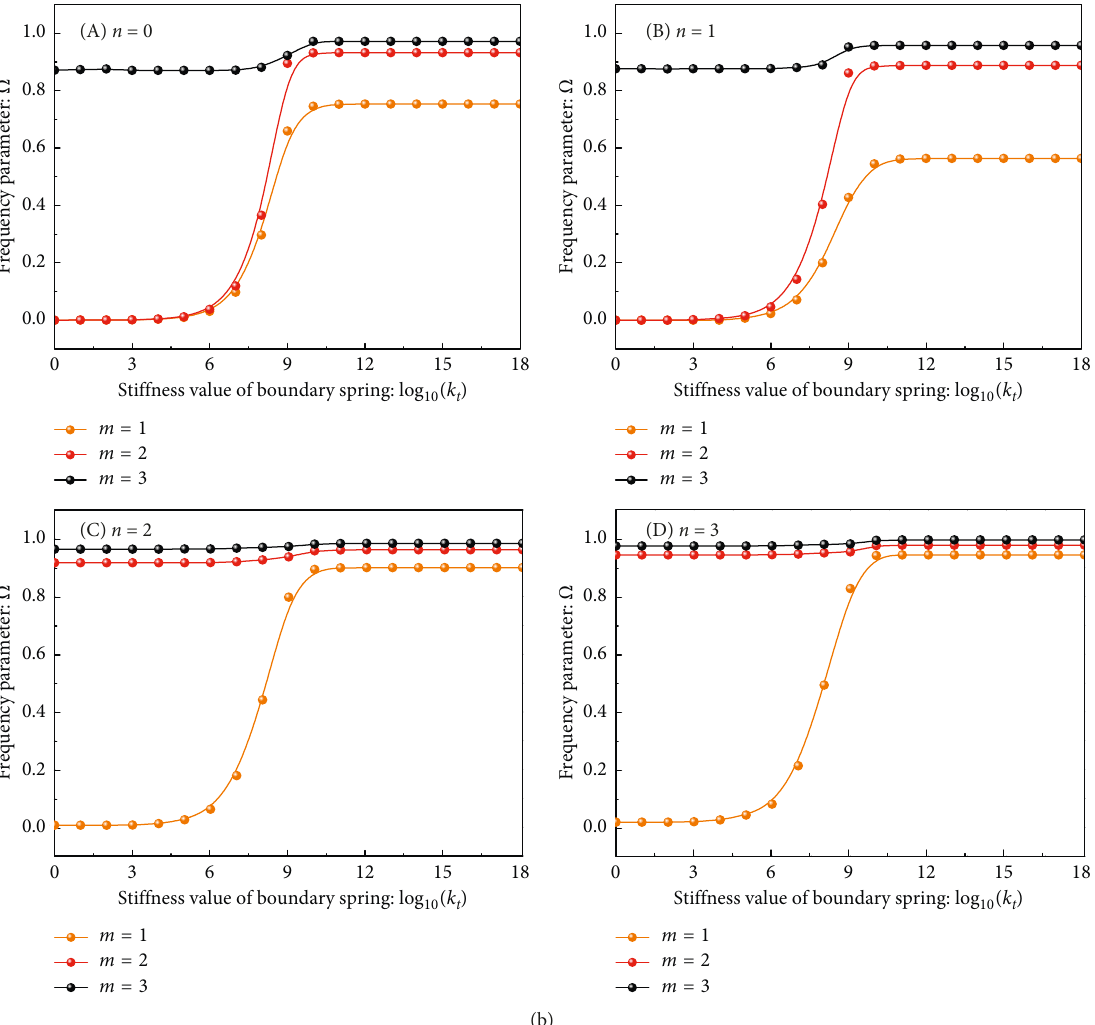
Figure 4: Nondimensional frequency Ω of spherical cap with different spring stiffness values: (a) connective spring; (b) boundary